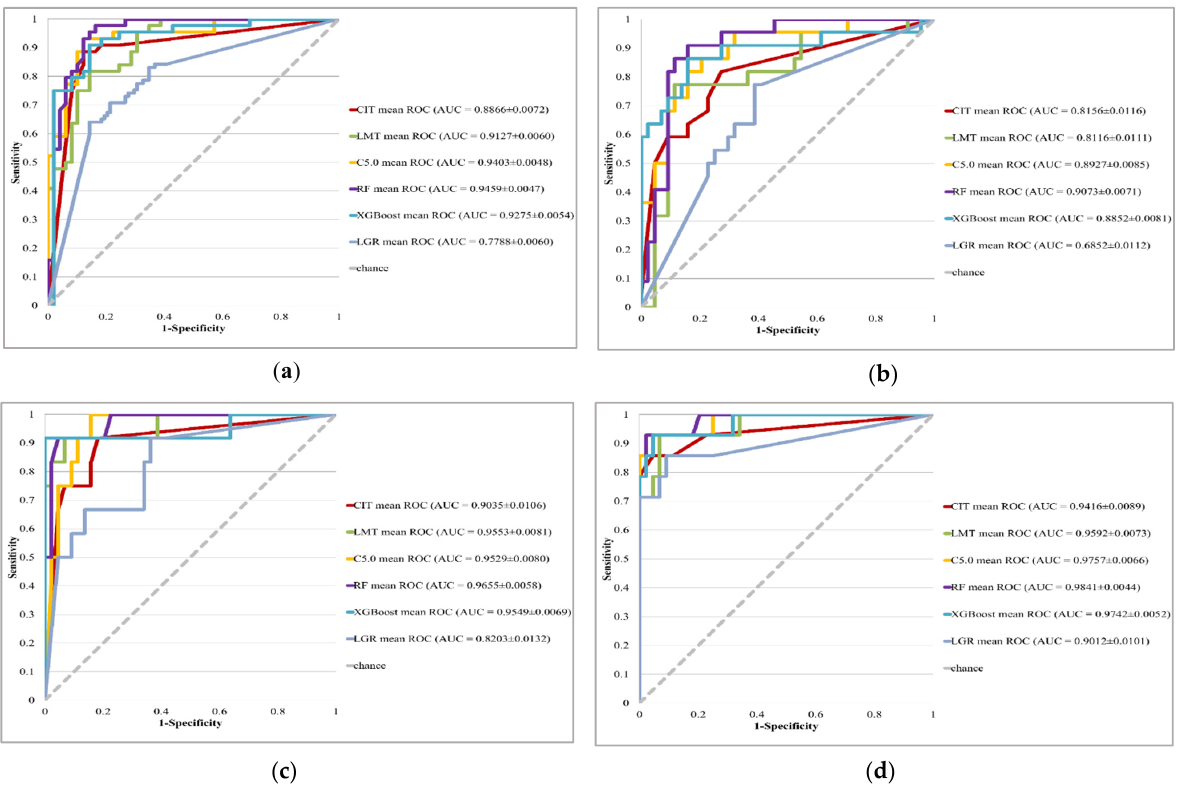
Figure 1. ROC curves of all classifiers for ( a ) all, ( b ) early, ( c ) moderate, and ( d ) severe glaucoma eyes. It can be observed from Table 2 and Figure 1a that all five MLCs can generate better performance than the benchmark LGR method (mean AUC = 0.7788) in all the glaucoma eyes datasets. RF provides the highest value of average accuracy (0.8818), average sensi- tivity (0.9166), average specificity (0.8507), and average AUC (0.9459). RF is the best pre- dictive model in all the glaucoma eyes datasets and its mean AUC and 95% CI is 0.9459 ± 0.0047. Referring to Table 3 and Figure 1b, it can be found that that the model performance of MLCs outperforms that of the benchmark LGR method (mean AUC = 0.6860) in the early dataset. The model performance of CIT and LMT are lower than that of C5.0, RF, and XGBoost algorithms. XGBoost receives the highest value of average sensitivity (0.7500) and RF generates the highest values of average accuracy (0.8550), average speci- ficity (0.9189), and average AUC (0.9073). RF is the best predictive model in the early glau- coma dataset and its mean AUC, and 95% CI is 0.9073 ± 0.0071. According to Table 4 and Figure 1c, we can find that the model performance of MLCs also outperforms that of LGR in the moderate dataset and all of the MLCs had excellent diagnostic performance, each with a mean AUC value greater than 0.9. The model perfor- mance of CIT is lower than other MLCs. XGBoost receives the highest value of average sensitivity (0.8392) and RF generates the highest values of average accuracy (0.9327), av- erage specificity (0.9646), and average AUC (0.9655). RF is still the best predictive model in the moderate dataset and its mean AUC, and 95% CI is 0.9655 ± 0.0058. Table 5 and Figure 1d show that the model performance of MLCs also outperforms LGR in the severe dataset. There is not much difference in the model performance among MLCs. CIT receives the highest value of average sensitivity (0.8787) and RF generates the highest values of average accuracy (0.9536), average specificity (0.9797), and average AUC (0.9841). RF is still the best predictive model for the severe glaucoma dataset and the mean AUC, and 95% CI is 0.9841 ± 0.0044. As the MLCs can generate promising classification performance for all three datasets and outperform the LGR model, they can be used to identify important variables for dis- criminating glaucomatous eyes from the normal eyes, and early, moderate, and severe glaucoma from normal conditions by ranking the importance of each variable within dif- ferent classifiers. For each model, the most important variable was ranked first (i.e., 1). On the contrary, the variable with the lowest importance was ranked as the last (i.e., 114). Supplemental Tables S2–S5 show the importance ranking of each variable of each classi- fier for all, early, moderate, and severe datasets, respectively. Taking Supplemental Table S2 as an example, GCL_T2 is found to be the most important variable in the C5.0 model, followed by MRW_TI and cRNFL_TS. For the ranking result of the RF model, the most important area is also GCL_T2, but the second- and third-most important areas are cRNFL_G and GCL_T1, respectively. It can be seen that different classifiers can generate different variable importance ranking results at different severities of glaucoma.